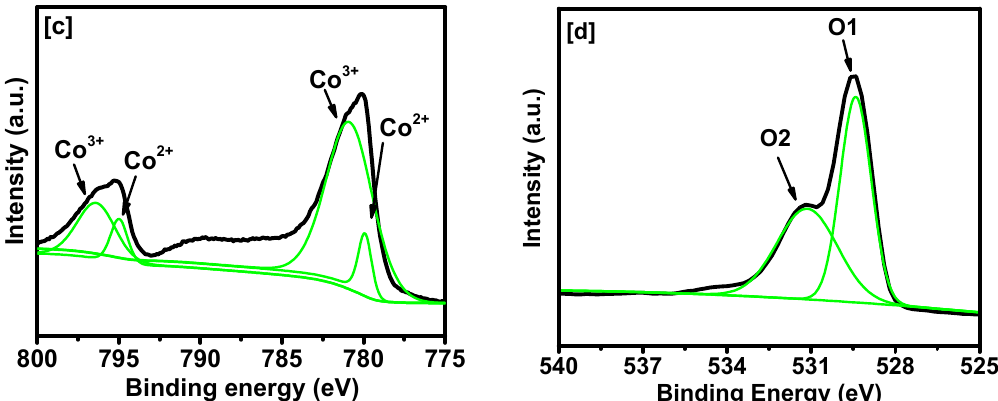
Figure 4. XPS spectra of the CuCo 2 O 4 : ( a ) full survey spectra, ( b ) Cu 2p spectrum, ( c ) Co 2p spectrum, and ( d ) O 1s spectrum.